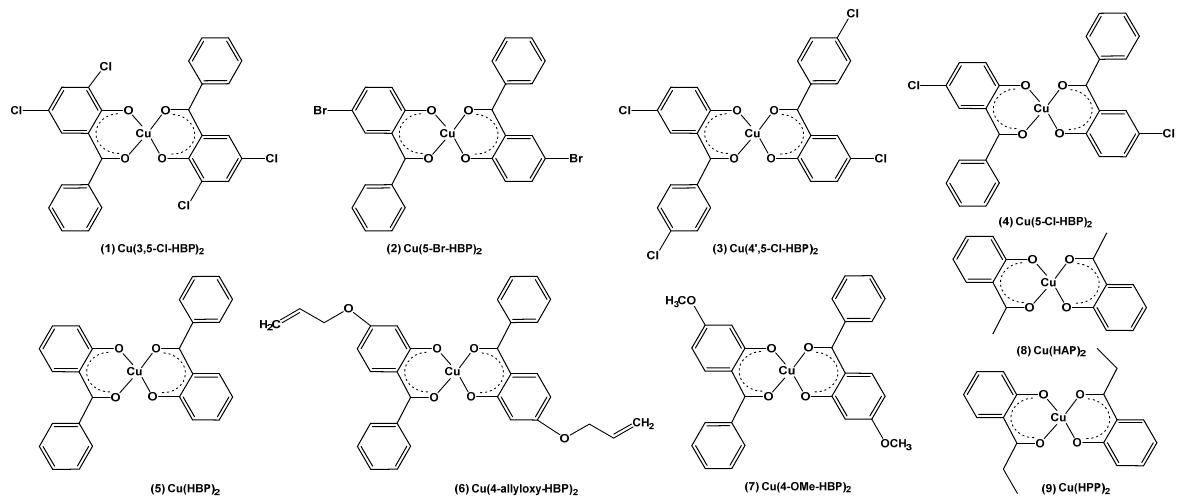
functionals overestimated the excitation energy (wavelength too low), while pure func- tionals (PW91, BP86, PBE) and asymptotically correct XC potentials (SAOP and LB94) overestimated the excitation energy. The B3LYP functional performed best, followed by PW6B95D3 and PBEh1PB . The B3LYP optimized ground state geometry were in good